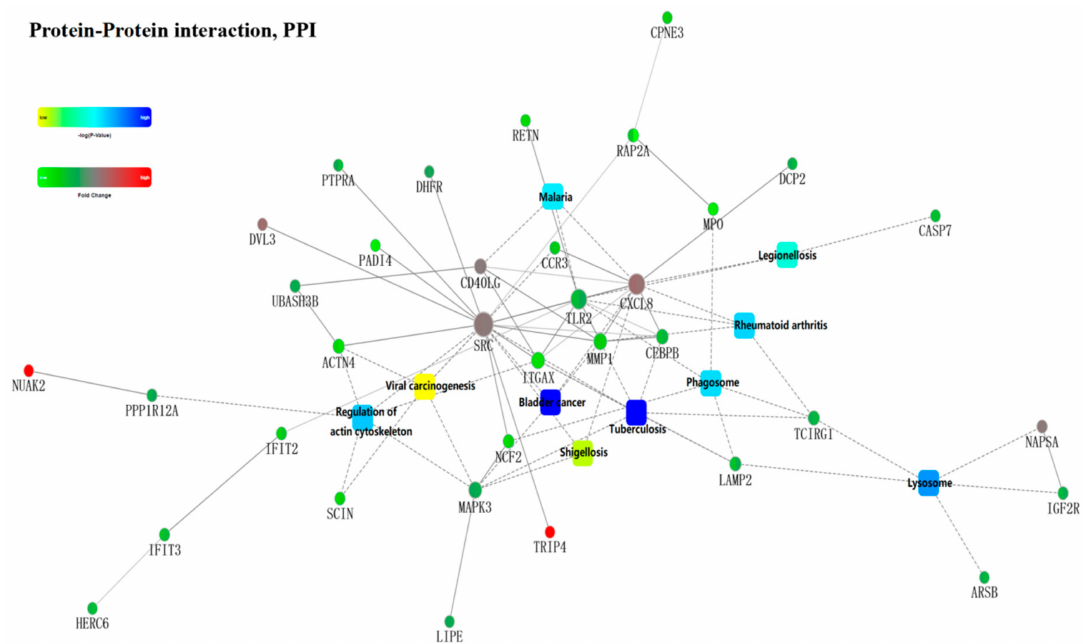
Figure 8. Protein–protein interaction